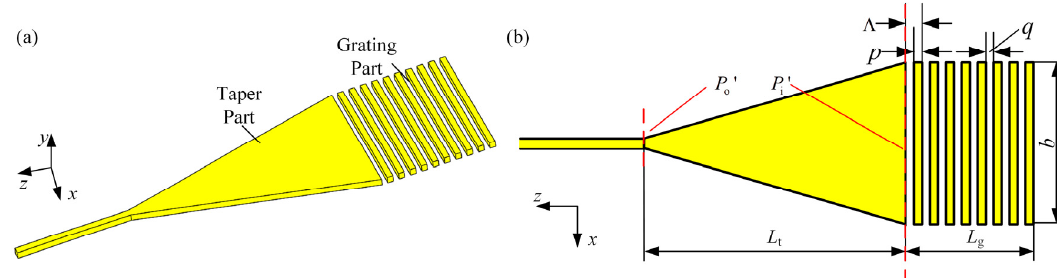
Figure 7. Structure of the grating coupler. ( a ) Three-dimensional view; ( b ) Top view.